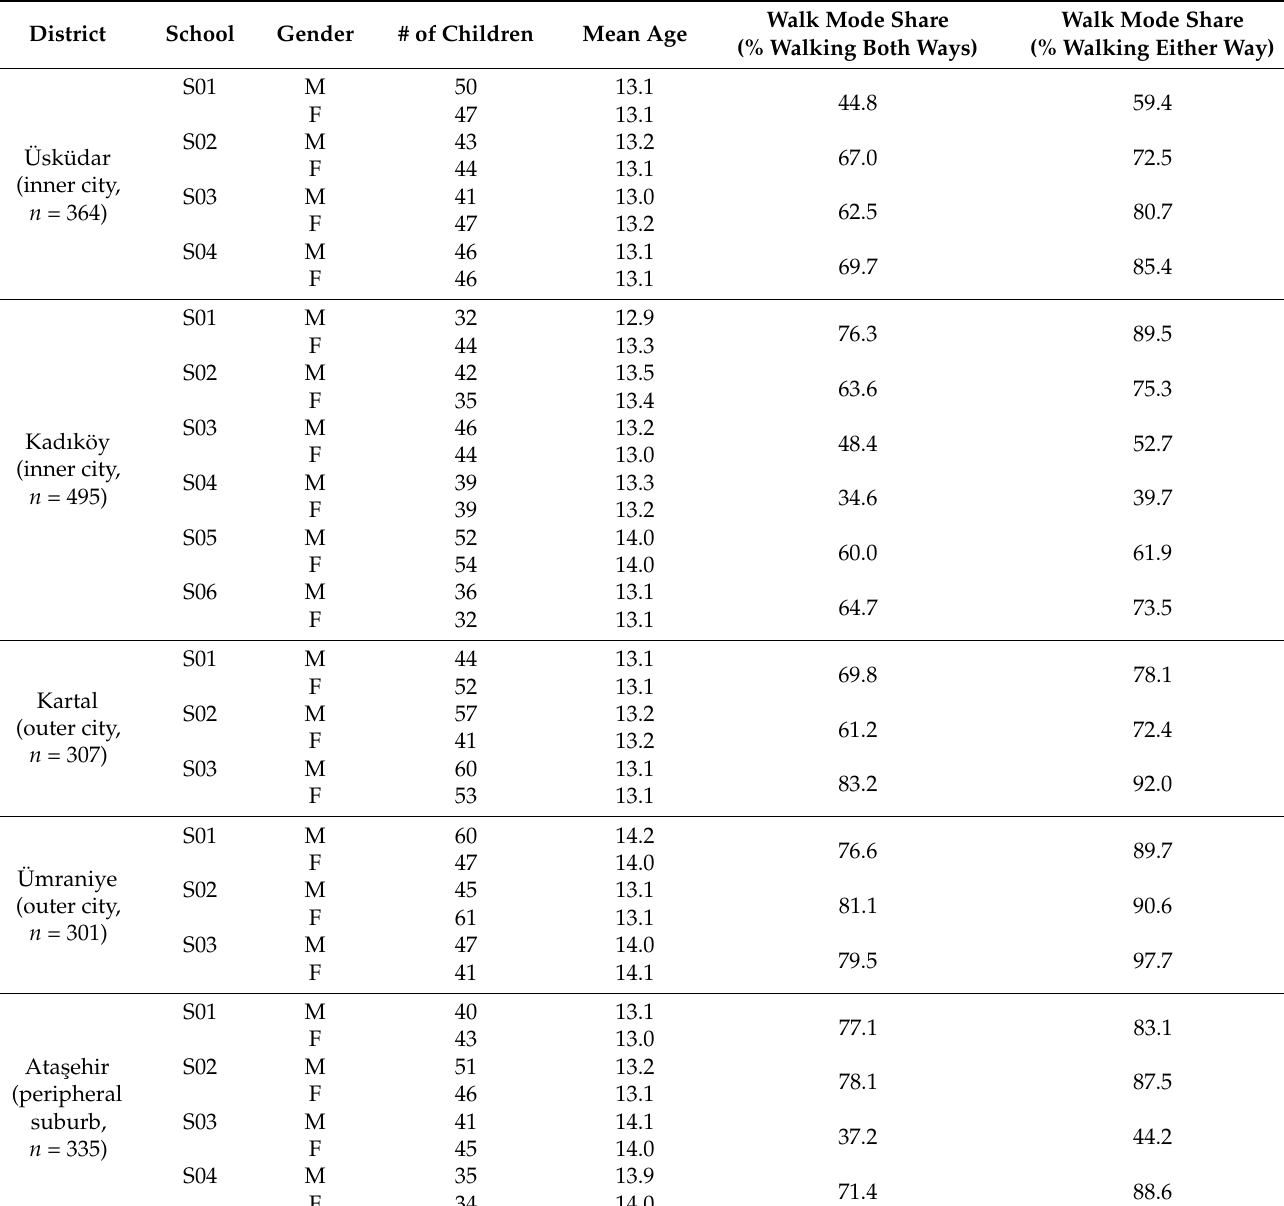
Table 2. Composition of study participants ( n = 1802) by district and school; number of children per school, average age and number of participating children per gender group and walk mode shares per school. District School Gender # of Children Mean Age